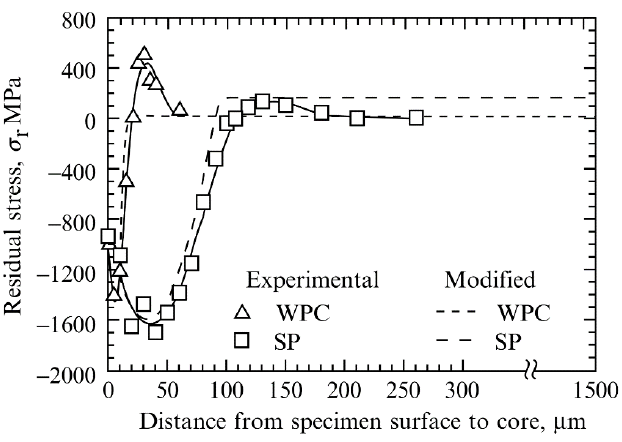
Figure 14. Experimental and modified results of residual stress distribution in SP-treated JIS SUJ2 steel specimens. The modified residual stress distribution shown by dashed lines reflects the stress redistribution after material surfaces were electropolished during the measurements. The specimens treated with 500 µm and 55 µm shots are noted as SP and WPC, respectively [10]. Reprinted with permission from Ref. [10]. Copyright 2002 Wiley.